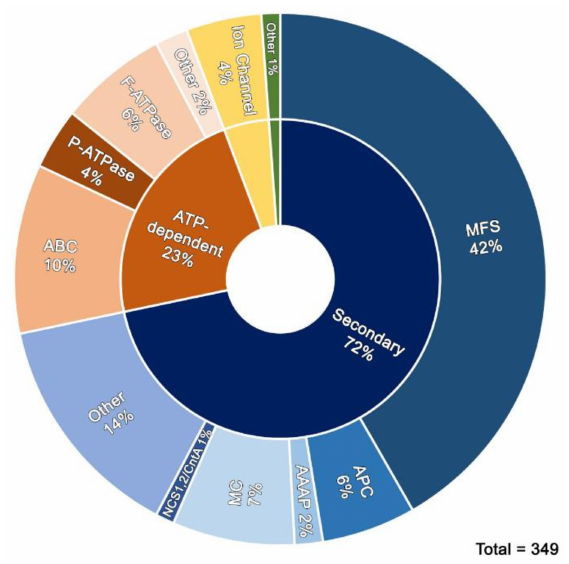
Figure 2. Pie chart of major transporter